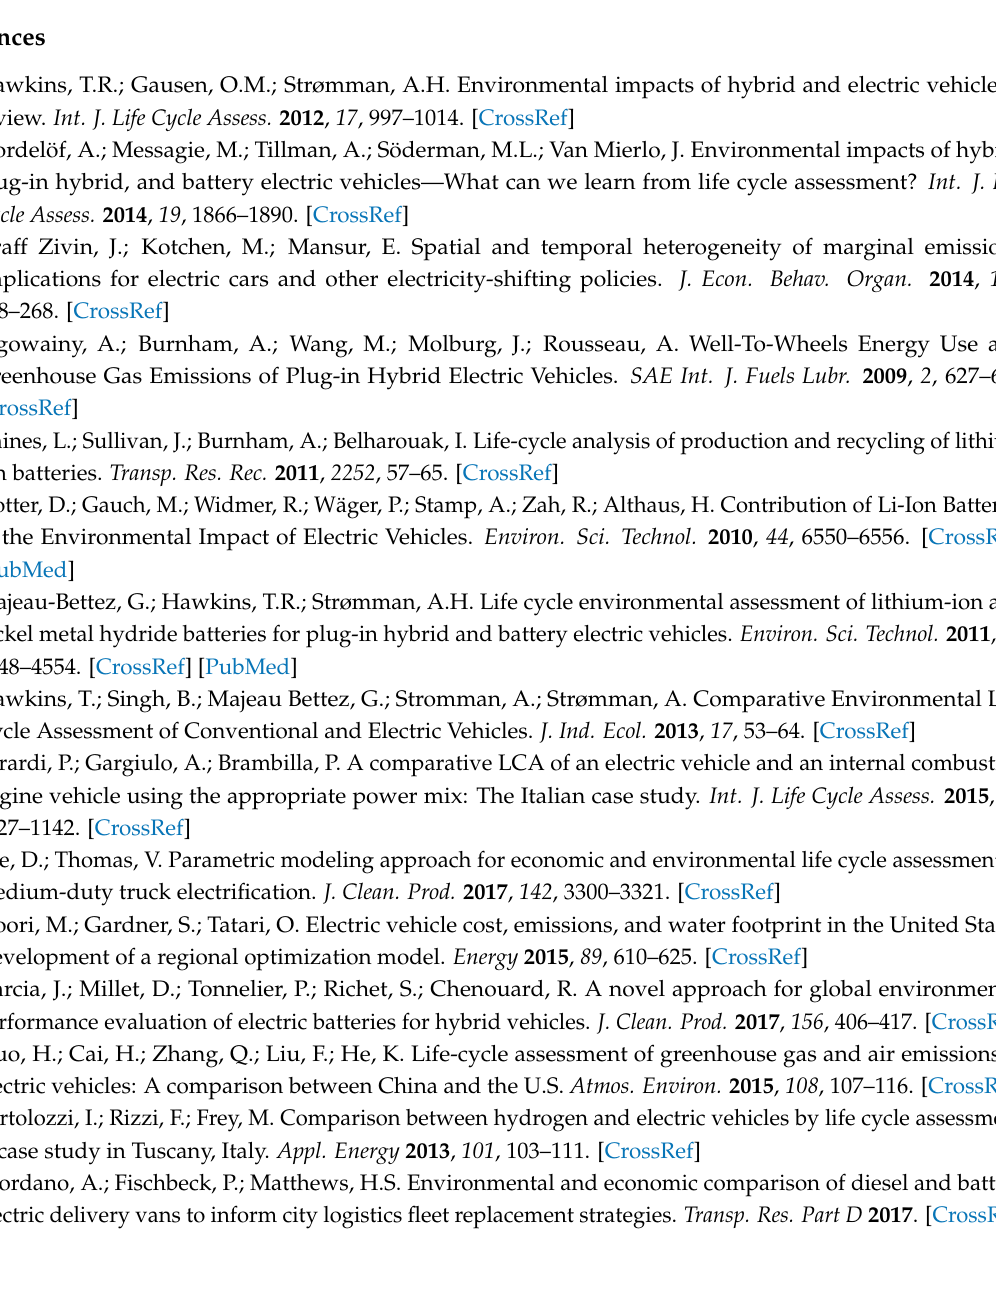
Figure S1: The literature results normalised at the most common indicator “g CO 2 -eq/km” (blue bars, left axis). If a study presents more than one value, the average value has been reported with the associated range. For studies that explicit electricity mix intensity, they are represented with a red dot (right axis); Figure S2: Studies reporting g CO 2 -eq/km and g CO 2 -eq/kWh in descending order of electricity carbon intensity; Table S1: Literature results and recommendations for practitioners and policy makers; Table S2. Framework for the main applications found in the